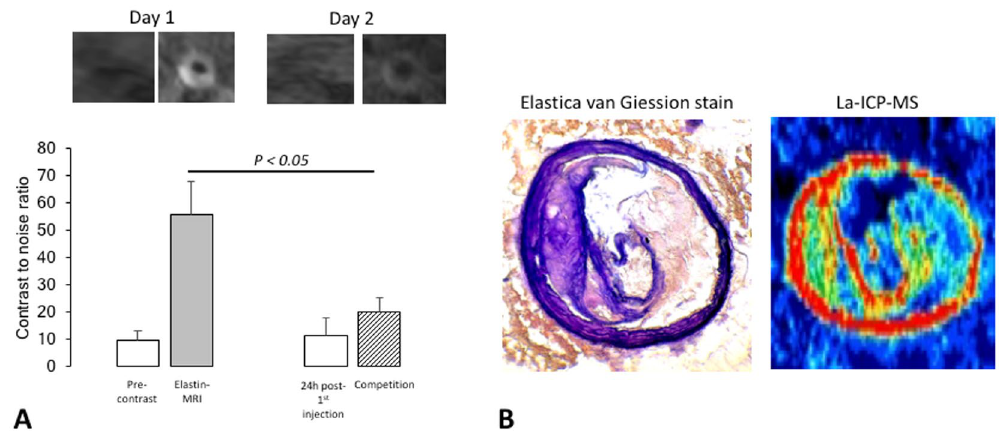
Figure 6. Competition experiments and laser ICP-MS for the mapping of the gadolinium distribution in an atherosclerotic-plaque. ( A ) First a pre-contrast scan was acquired on day one. In the next step 0.2 mmol/kg of the gadolinium-based elastin-specific probe was administered to assess the uptake of the probe in the vessel- wall. After 24-hours, a pre-contrast scan was repeated to confirm the washout of the agent. For the competition experiments, a tenfold-higher dose of non-paramagnetic europium-labeled elastin-specific MR-probe was administered prior to the application of 0.2 mmol/kg of the gadolinium-based elastin-specific probe. This resulted in a marked decrease of the contrast-to-noise-ratio compared to the administration of the gadolinium labeled elastin-specific agent alone. The in vivo competition experiments were performed in ApoE − / − mice (n = 3) on a four-months high-fat-diet. ( B ) Spatial localization of the gadolinium-based elastin-specific probe using LA-ICP-MS. Signal from gadolinium across the arterial-wall sample (n = 3) was mapped to determine the distribution of gadolinium. Co–localization of targeted gadolinium with elastic-fibers was